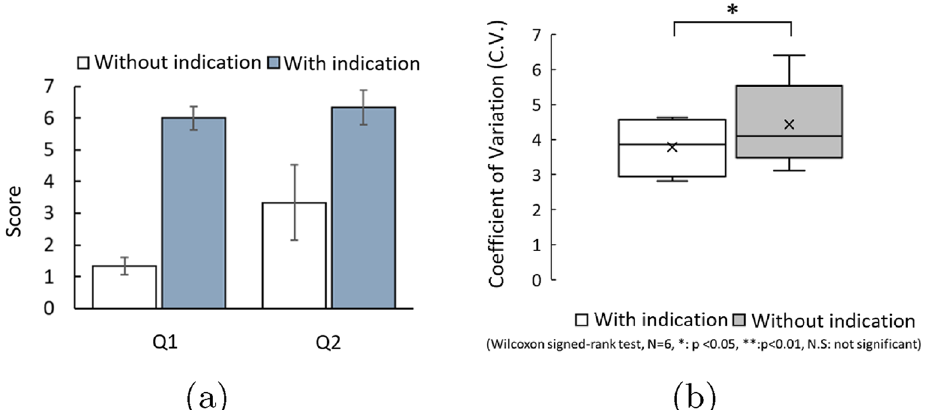
Fig. 8 Qualitative and quantitative evaluation results. a Survey answer scores. b Coefficient of Variation with/without the use of Preliminary Indication